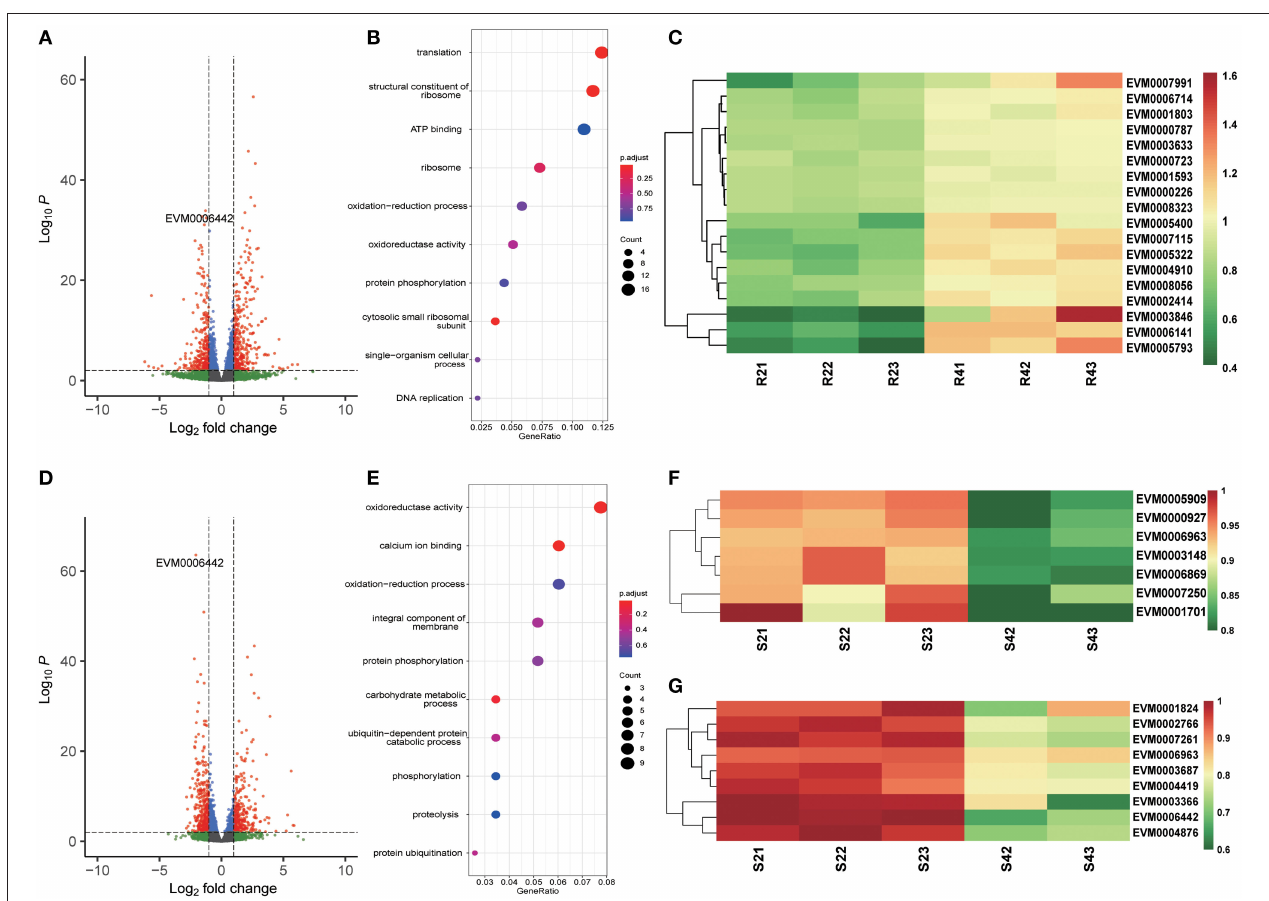
FIGURE 4 | Differential gene expression after 4h of monensin treatment. Volcano plots showing differentially expressed genes in the monensin-resistant ETH-R strain (A) and the monensin-sensitive ETH-S strain (D) after 4h of monensin treatment. Genes with an absolute fold change > 2 and adjusted p < 0.01 were considered significantly differentially expressed (red dots). (B,E) Gene ontology enrichment of differentially expressed genes in ETH-R (B) and ETH-S (E) after two additional hours of monensin treatment (4 vs. 2h). (C) Heatmap showing differentially expressed genes associated with ribosomal proteins in the monensin-resistant ETH-R strain after two additional hours of monensin treatment. (F,G) Heatmaps showing differentially expressed genes associated with calcium ion binding proteins (F) and oxidoreductive proteins (G) in the monensin-sensitive ETH-S strain after two additional hours of monensin treatment. For heatmap drawing, gene expression levels were transformed into normalized log 2 (TPM +